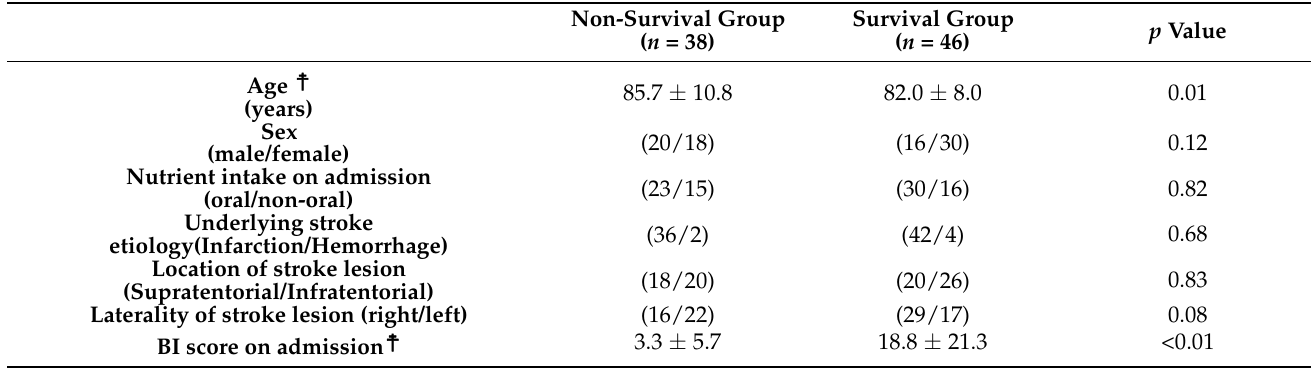
Table 2. Results of the polytomous logistic regression analysis.